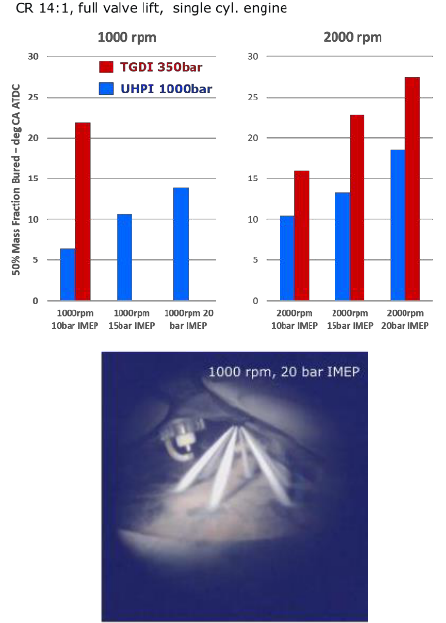
Fig. 18. “Knock-Free Engine”; Ultra High Injection Pressure